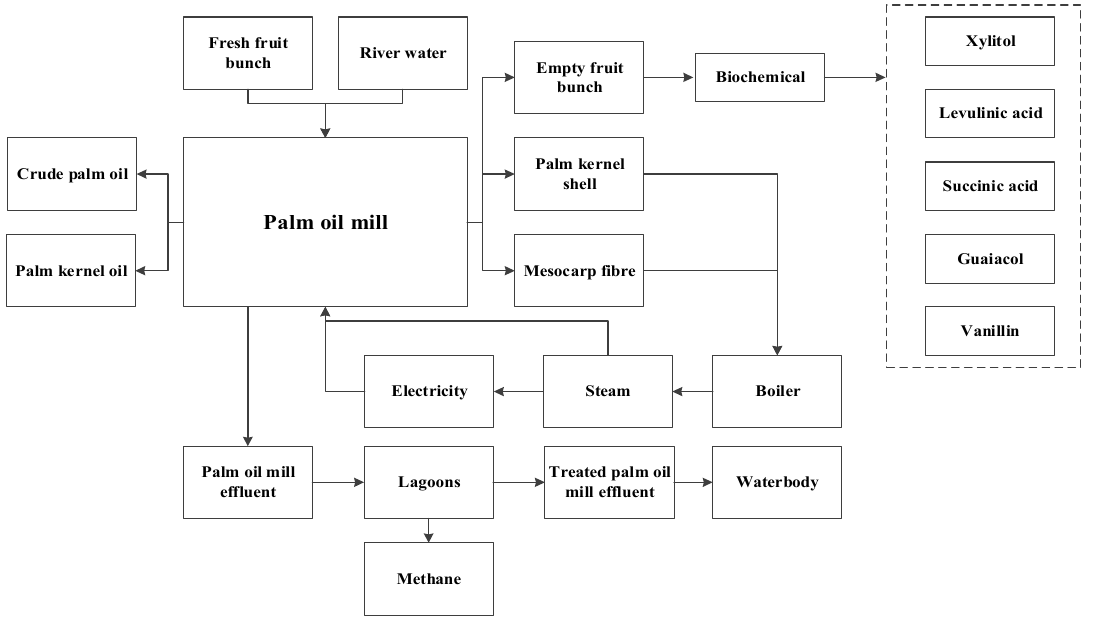
Figure 1. Palm-oil-based integrated biorefinery concept [55].